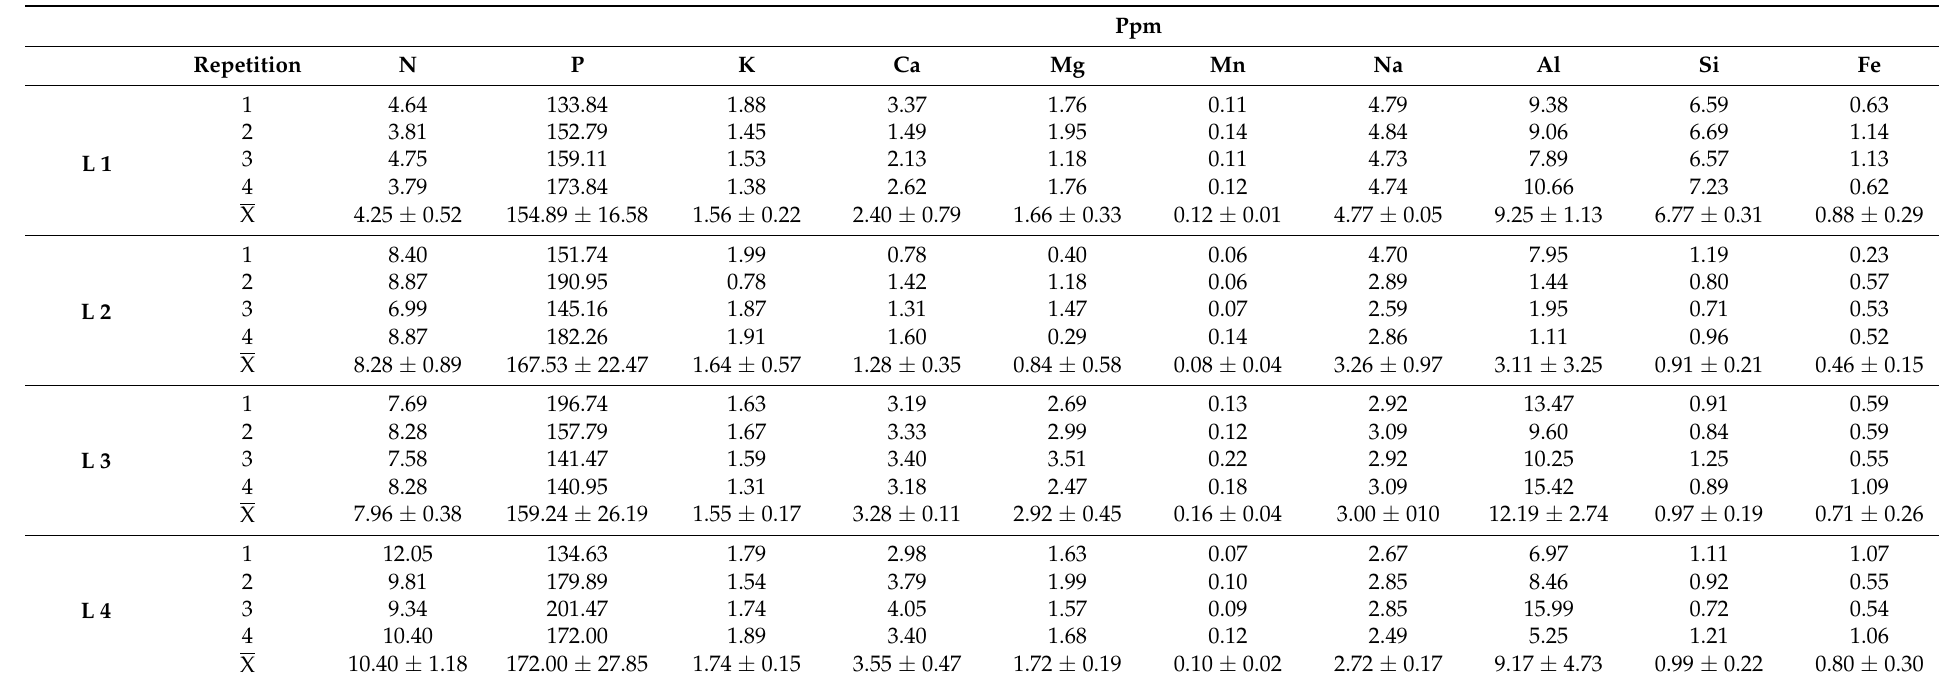
Table 5. Plant chemical composition in the four